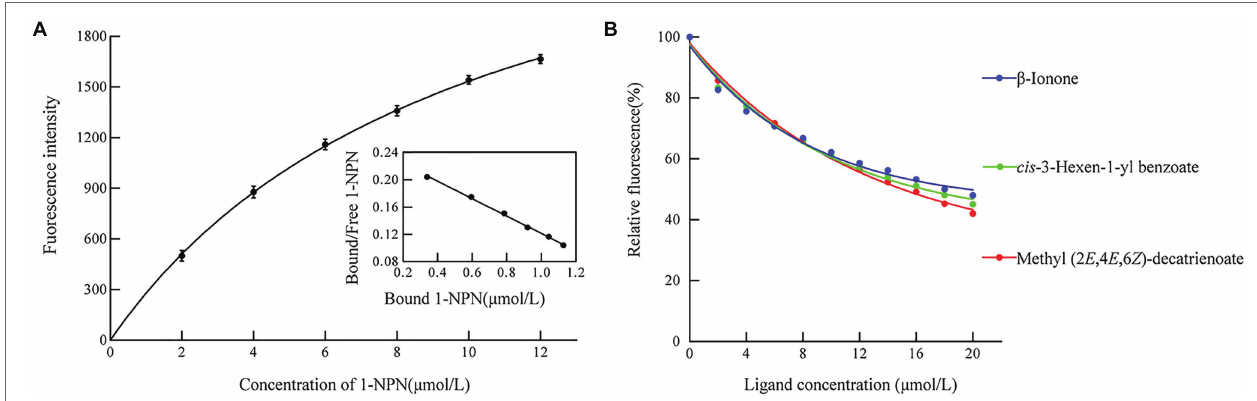
FIGURE 4 | Binding properties of recombinant HhalCSP15. (A) Binding curve and Scatchard plot of N-phenyl-1-naphthylamine (1-NPN) to HhalCSP15. (B) Binding curves of HhalCSP15 to candidate